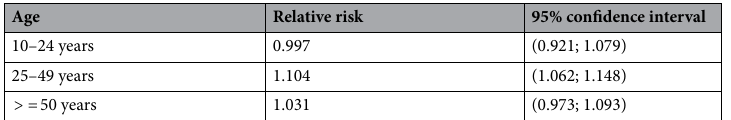
Table 3. Temporal trend of the risk of all-type hospitalized cases coded endometriosis according to age.